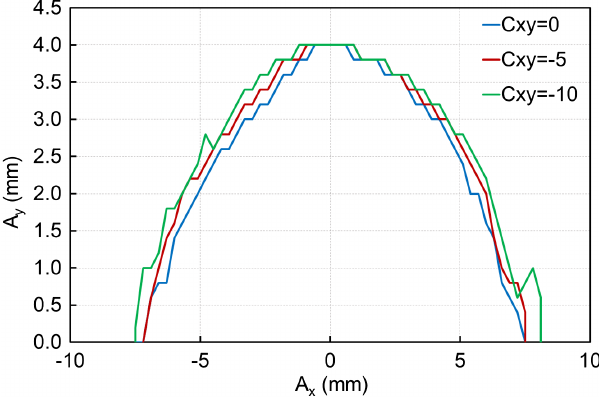
29. Dynamic aperture of 6 GeV light source for three values of under-compensated chromaticity.